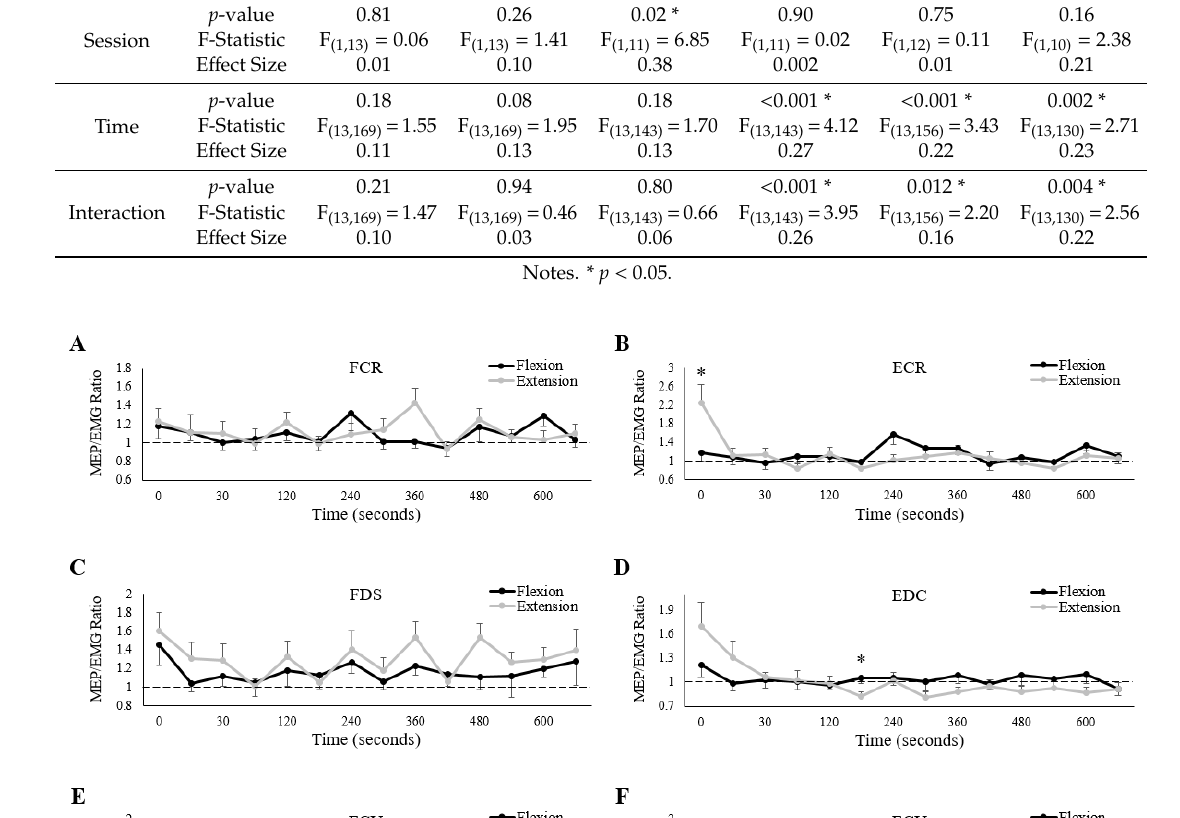
Table 5. Results from two-way repeated measures ANOVAs performed on ratios of MEP amplitudes (% of baseline) and pre-stimulus muscle activity (% of baseline).